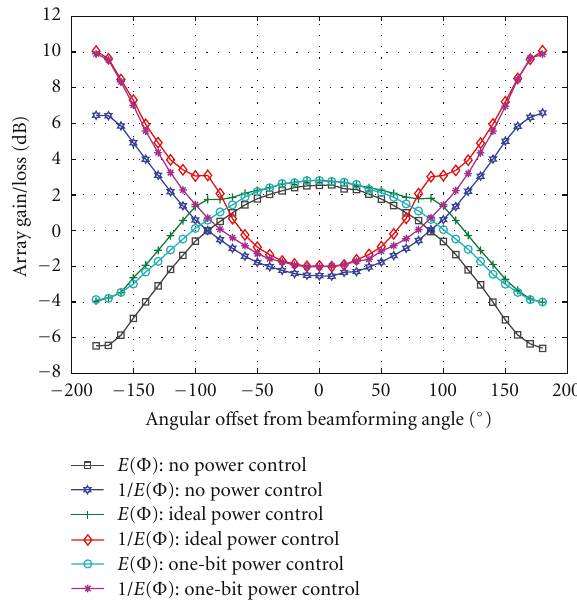
Figure 3: The array gain seen in a 2 Tx × 1 Rx antenna configuration for varying o ff set angle with 1 − bit power